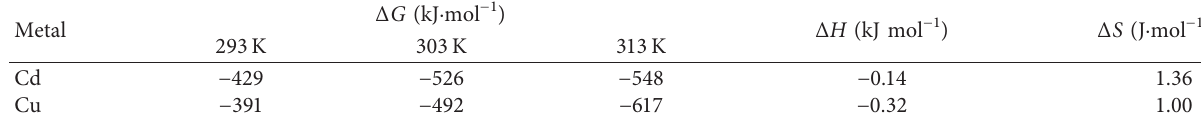
Table 1: Thermodynamic parameters of Cd(II) and Cu(II) adsorption on PS.